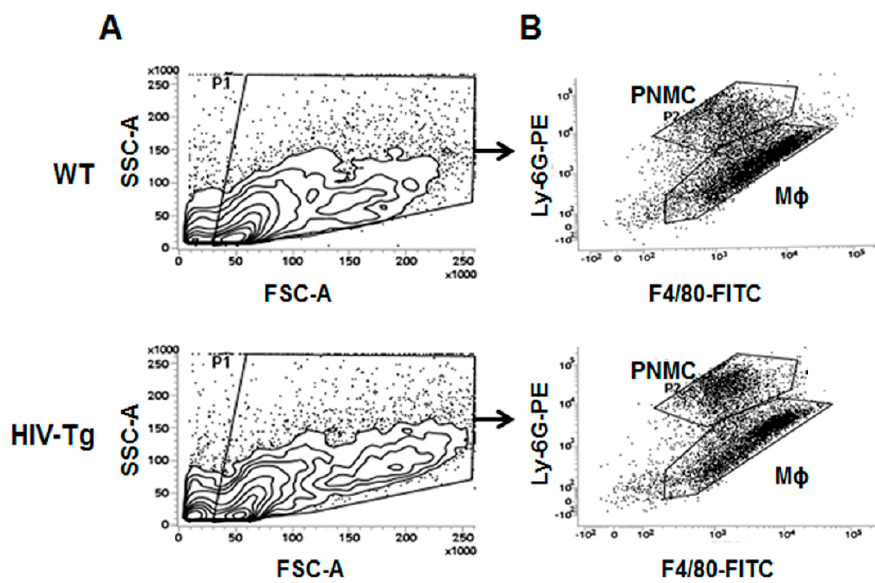
Figure A3. Gate strategy for flow cytometry of cells isolated from lungs at 24h after LPS administration in WT and HIV-Tg mice. ( A ) Lung cells isolated from WT and HIV-Tg were gated as shown for FSC-A and SSC-A scattering. ( B ) Flow cytometry for double-stained neutrophil (Ly-6-PE) and macrophage (F4/80) markers. Gates show population of neutrophil (PNMC) and macrophage (M ϕ ) in WT and HIV-Tg mice.